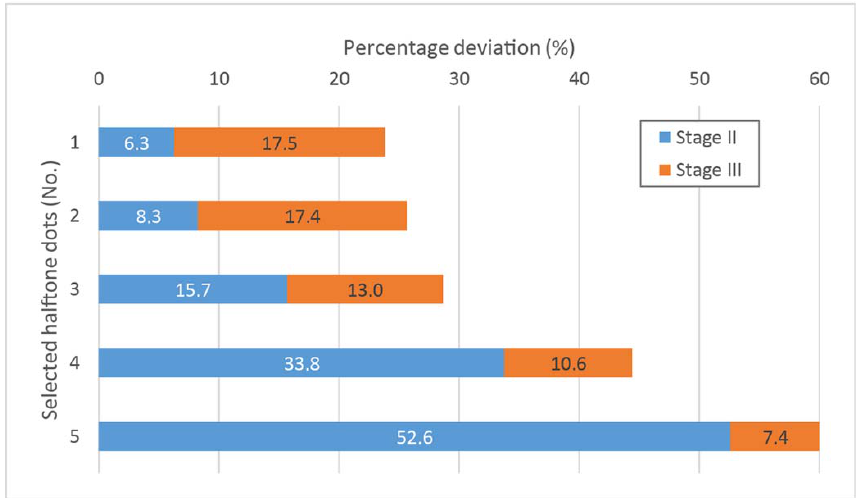
Figure 5. Absolute increase of dot coverage values for five selected halftone dots at Stage II and Stage III.